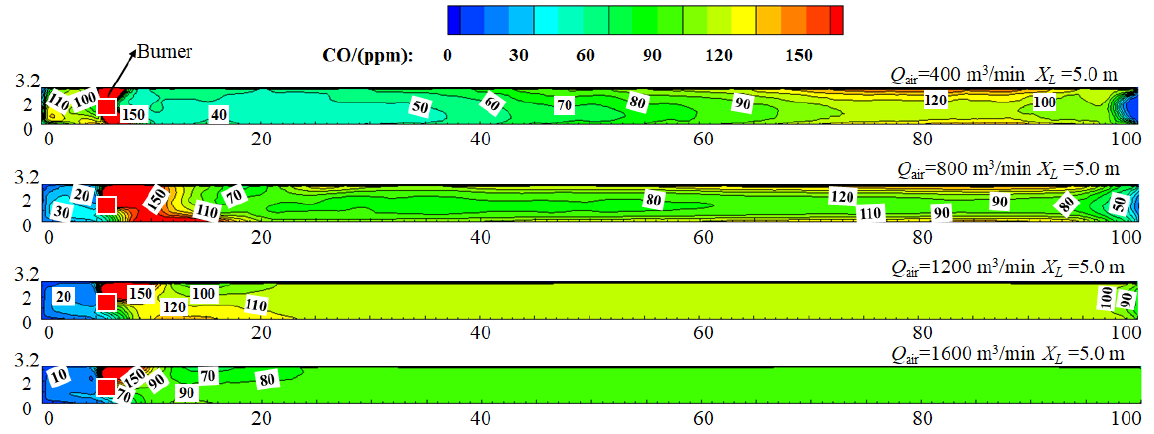
Figure 15. The CO concentration distribution at the height Z = 1.6 m under different air